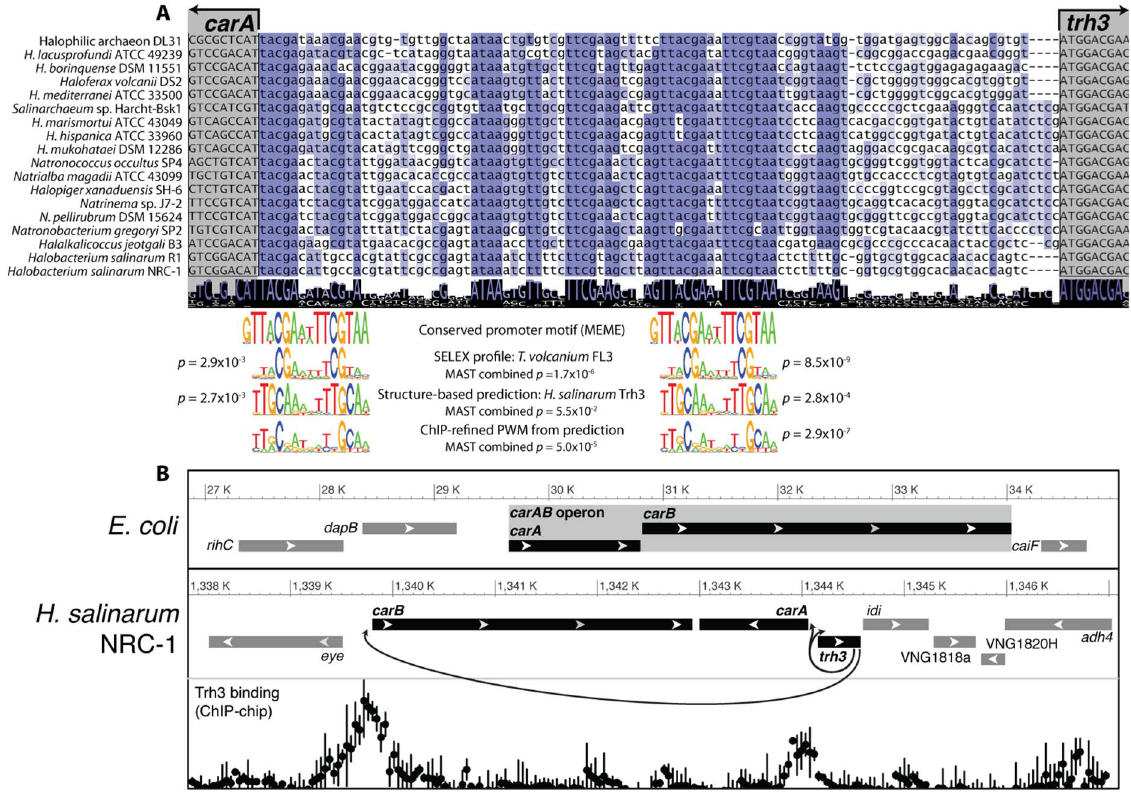
Figure 4. Prediction of cis -regulation by Trh3. A) Structure-based prediction of the Trh3 TFBS is similar to two DNA sequence regions in the shared carA/trh3 promoter region that are conserved across eighteen halobacterial species. The experimentally measured TFBS of the Trh3 ortholog FL3 from T. volcanium also matches these conserved cis -regulatory sequences. B) In halobacterial species, the trh3 gene product is a transcription factor that transcriptionally coordinates the expression of genomically separated subunits of carbamoyl phosphate synthetase ( carA and carB ), as well as itself.